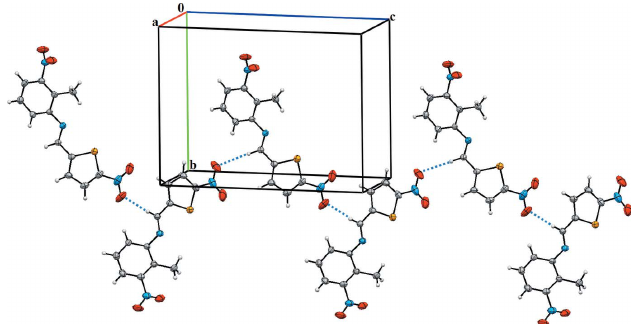
N—O bond lengths in the nitro groups in the title compound are the same within standard deviations as the corresponding